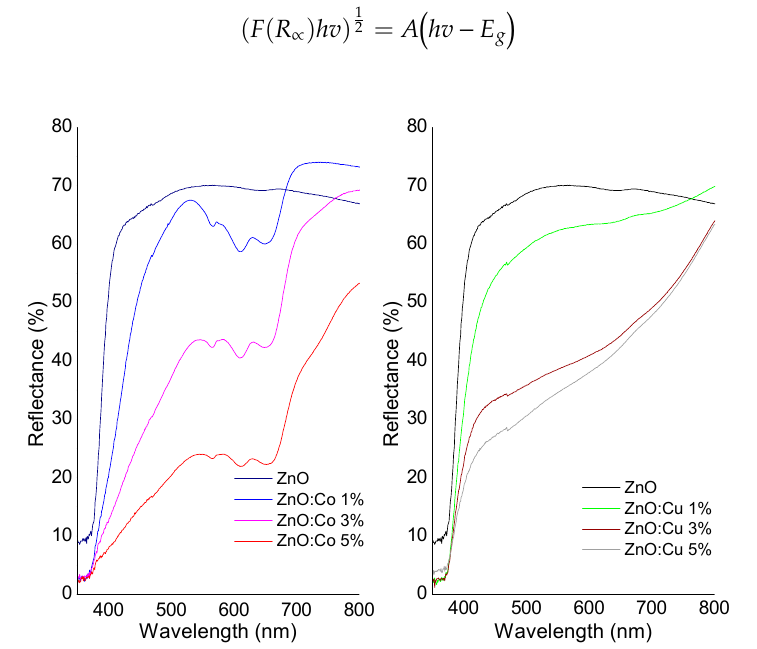
Figure 4. Reflectance diffuse spectra for both catalysts.